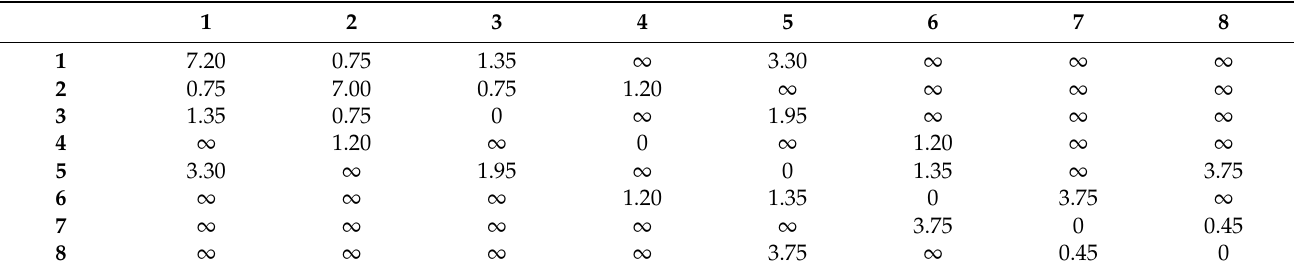
Table 2. Matrix of unit prices for road